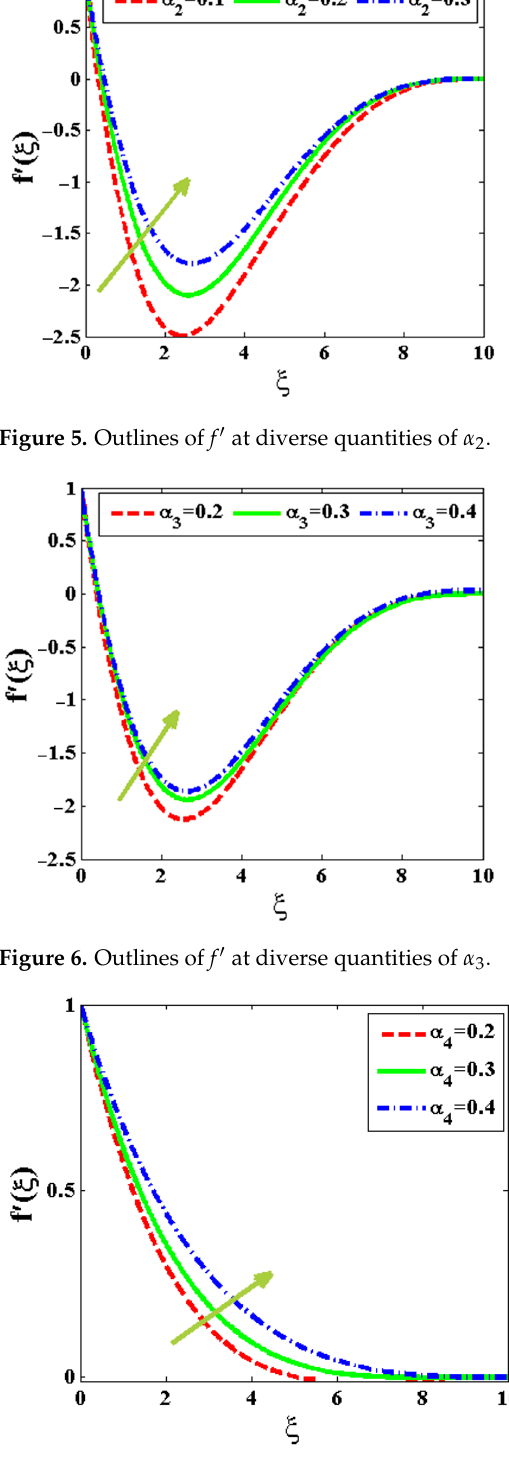
Figure 7. Outlines of 𝑓 ′ at diverse quantities of 𝛼 (cid:2872) .